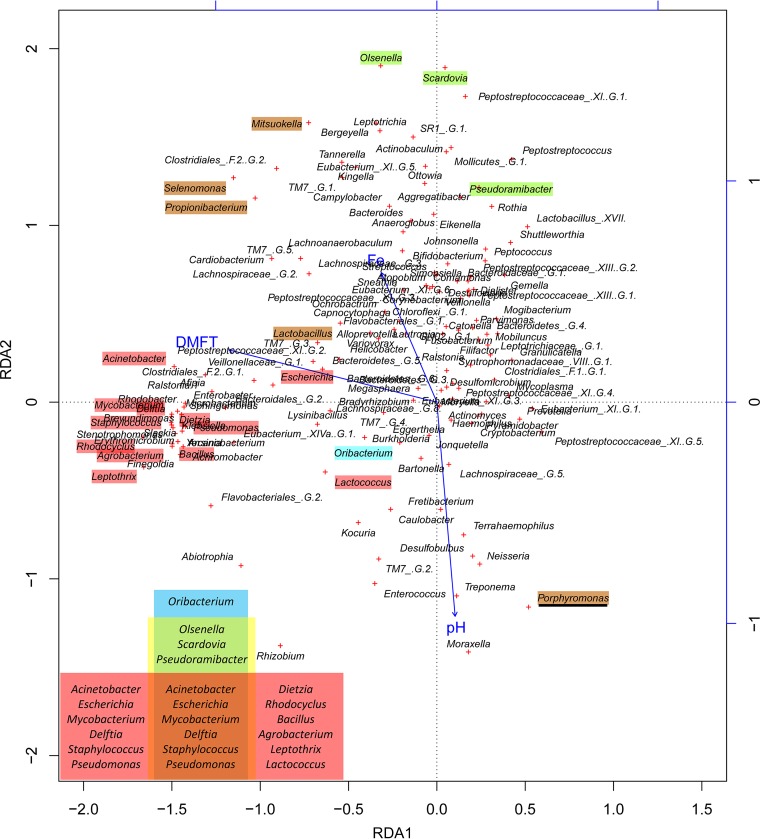
Redundancy analysis (RDA) of the significant influences of the salivary pH, iron concentration, and DMFT index on the bacterial community structure at the genus level. Colors indicate the non-caries-associated (underlined) and caries-associated genera. These distinct genera with high correlations with one or more variables are explained by the Venn diagram inserted in the plot: yellow, blue, and red indicate genera with high correlations (>0.6) with iron concentration, pH, and DMFT, respectively.